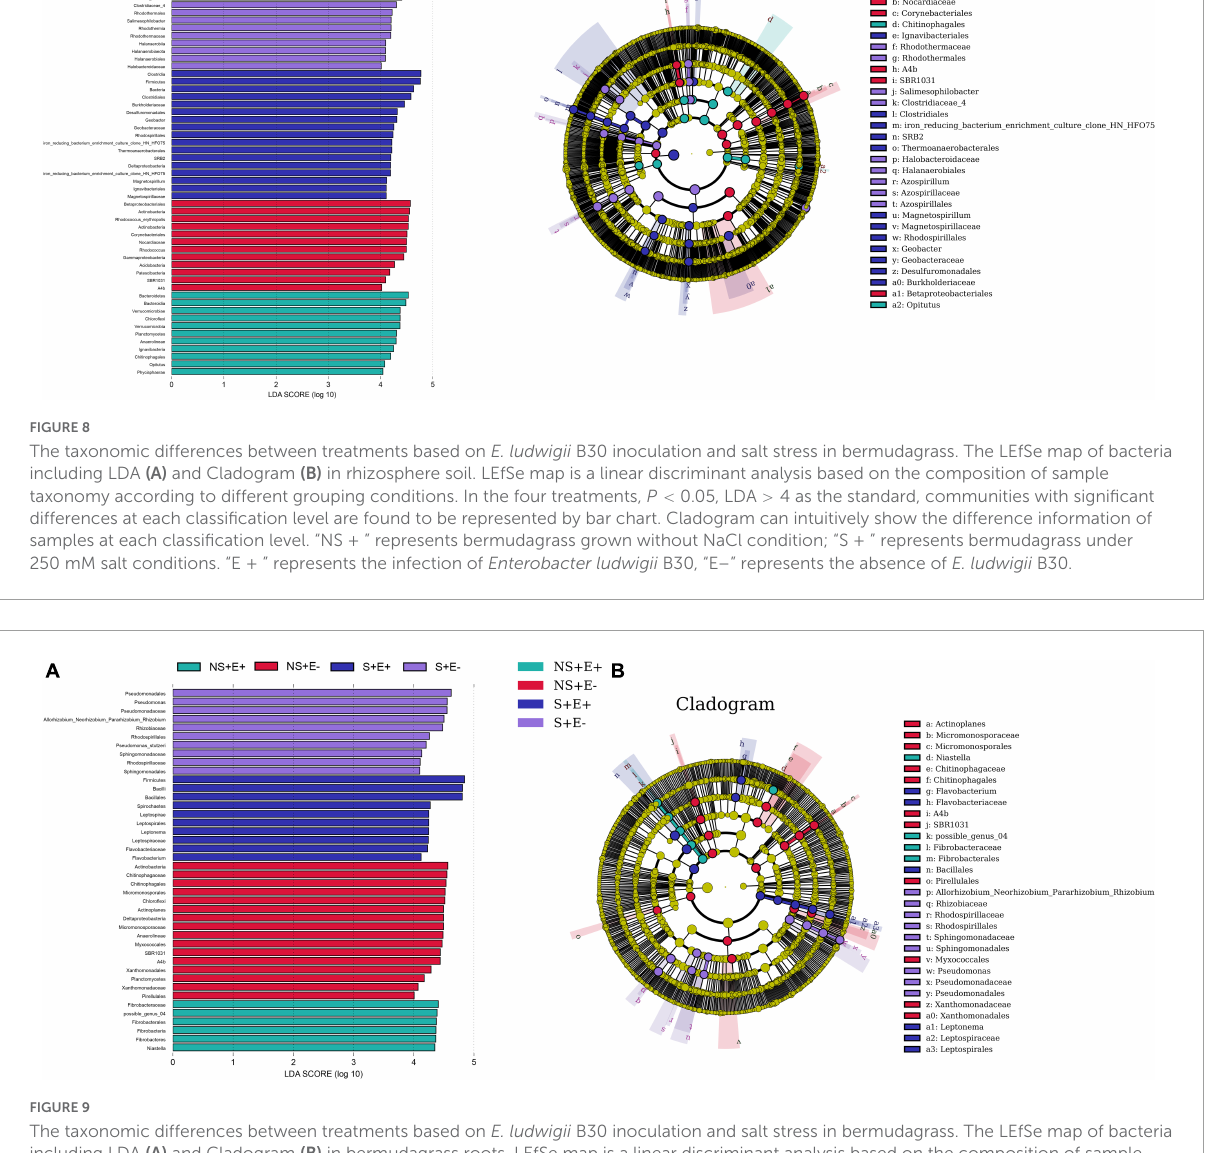
plants from the four treatments in bermudagrass roots ( Figure 9B ). Nine genus clades, including Pseudomonas , Allorhizobium_Neorhizobium_Pararhizobium_Rhizobium , Pseudomonas_stutzeri, and Erythrobacter from S + E–; Spirochetes and Flavobacterium from S + E + ; Chitinophagales and Actinoplanes from NS + E–; and possible_genus_04 from NS + E +